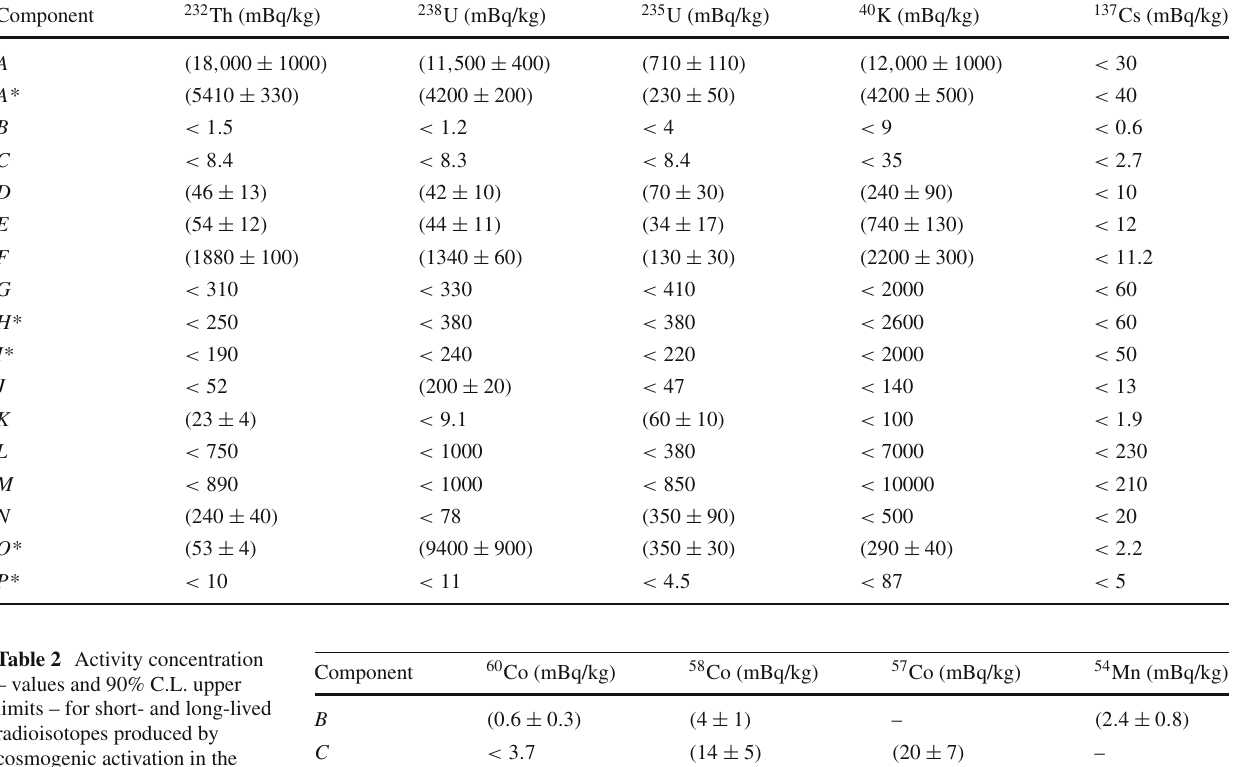
Table 1 Bulk contamination – values and 90% C.L. upper limits – of the materials located in the proximity of the qubit at the 15 mK stage (A–L) and 4K (M,N) stage. Items indicated with (*) were measured for general interest but will not be used in the Round Robin measurements.